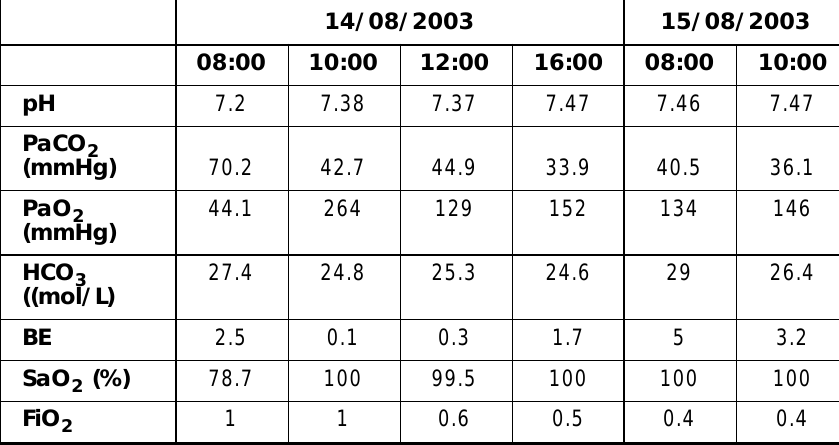
Table 1: Arterial Blood Gas Results